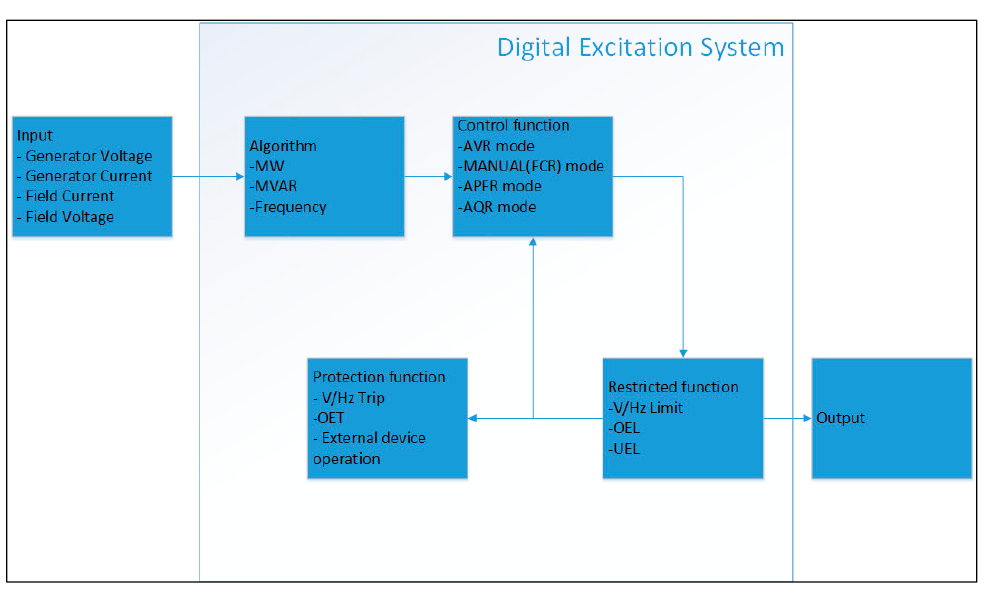
Figure 6. Digital excitation system algorithm.